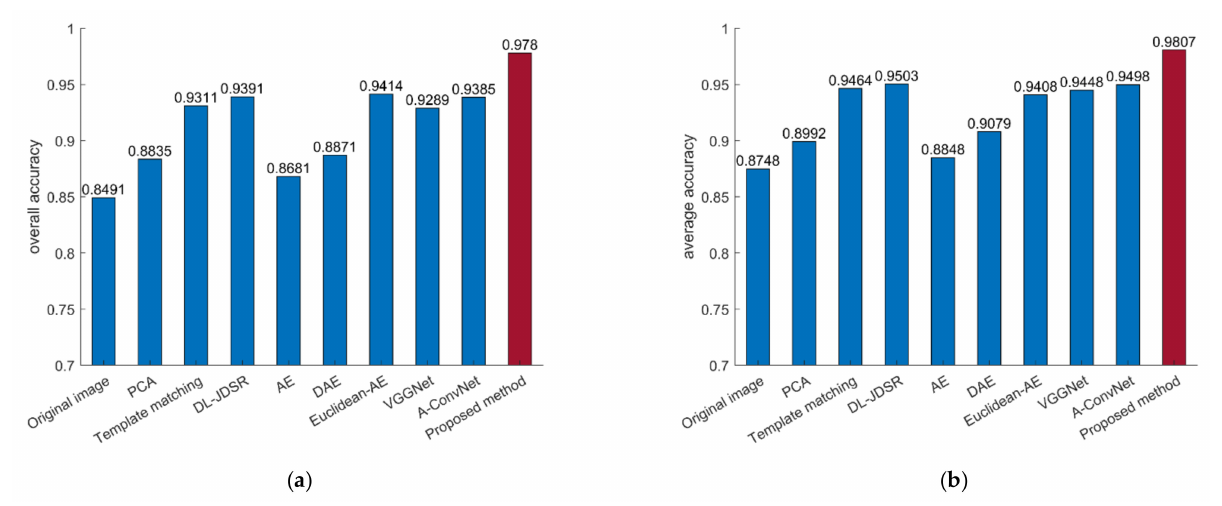
Figure 7. Three-target accuracies obtained by different SAR target recognition methods. ( a ) overall accuracy; ( b ) average